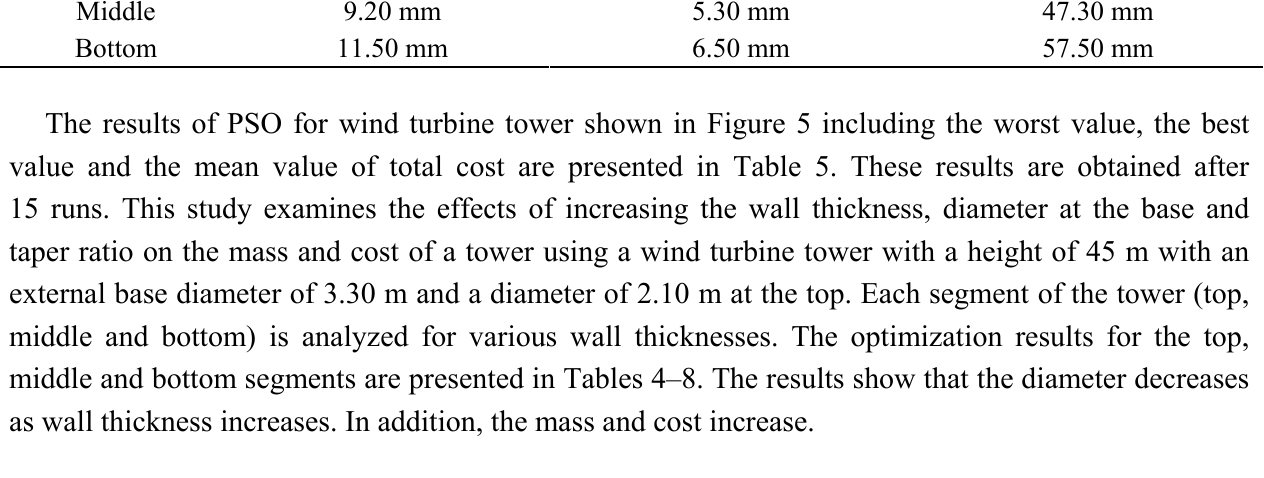
Table 5. Results of PSO for wind turbine tower.